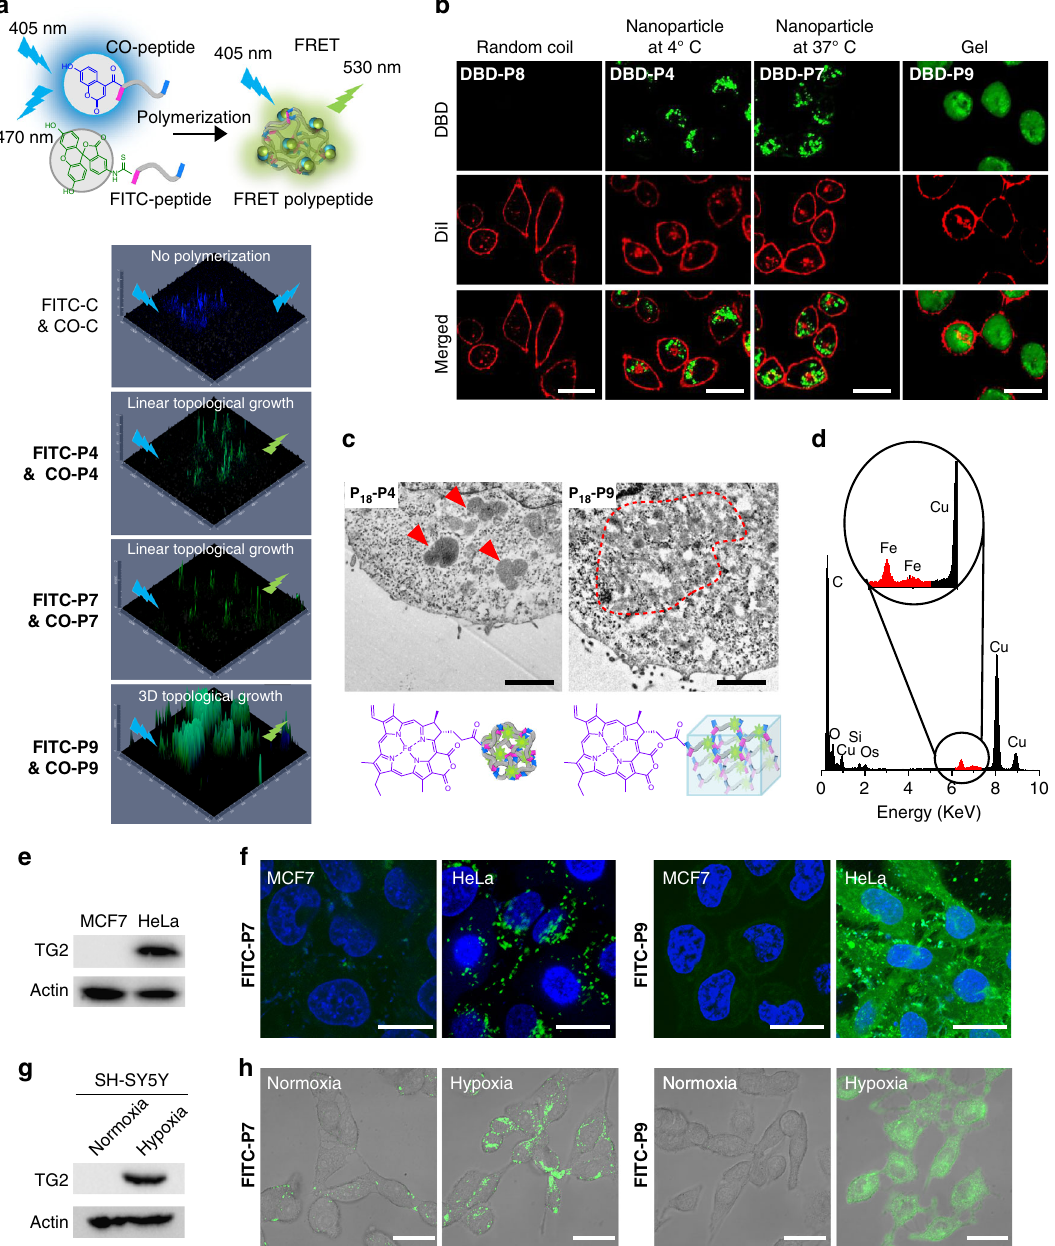
Fig. 3 Intracellular polymerization and in situ aggregation of peptide monomers. a TG2-catalyzed intracellular polymerization of peptide monomers was monitored by fl uorescent resonance energy transfer (FRET) technique. The 3D confocal images displayed the FRET effect of control, P4 , P7 , and P9 inside HeLa cells at 12 h-post treatment. The feed ratio of FITC-peptide ( fl uorescein isothiocyannate-peptide) and CO-peptide (coumarin-peptide) was 1:1. b Confocal images displayed the nanostructures (green) formed from P4 (at 4 °C) and ( P7 , P9 ) (at 37 °C). P8 , P4 , P7 , and P9 were ELP random coil, UCST- type ELP, LCST-type ELP, and ELP gel, respectively. Cell membrane, red. Scale bar, 30 μ m. c The ultrathin cell sections of HeLa cells. Fe-chelated P 18 was used to identify the formed nanostructures and for contrast enhancement. Red arrows indicated P 18 -P4 3D nanoparticles; red dotted circle indicated P 18 -P9 gel. Scale bar, 1 μ m. d Energy dispersive spectrometry (EDS) of the nanostructures formed from P 18 -P4 . The Fe element signal (red highlighted) made the P 18 -P4 from the biological background stand out. e MCF-7 and HeLa cells were lysed. TG2 protein was examined by western blotting. f Fluorescein isothiocyannate (FITC)-labeled P7 and P9 were incubated with MCF-7 or HeLa cells for fl uorescence imaging. FITC-P7 and FITC-P9 , green; nucleus, blue. Scale bar, 30 μ m. g The expression of TG2 protein in SH-SY5Y cells was modulated by normoxia (N) and hypoxia (H) conditions. h Peptide monomer polymerization and in situ aggregation was dependent on the expression of TG2. FITC-P7 and FITC-P9 , green. Scale bar, 50 μ